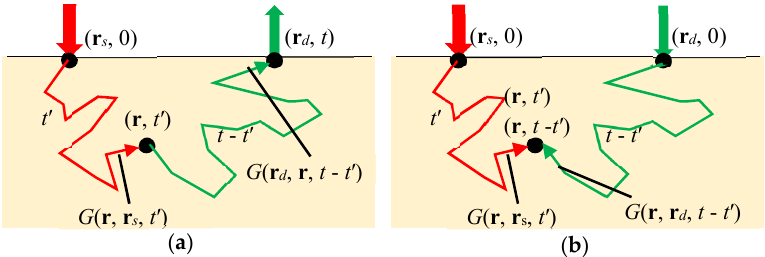
Figure 5. ( a ) Light propagation from the source position, r s , to the detector position, r d , through an arbitrary position, r . ( b ) Light propagation from the source position, r s , to the position, r , and from the detector position, r d , to the position, r .